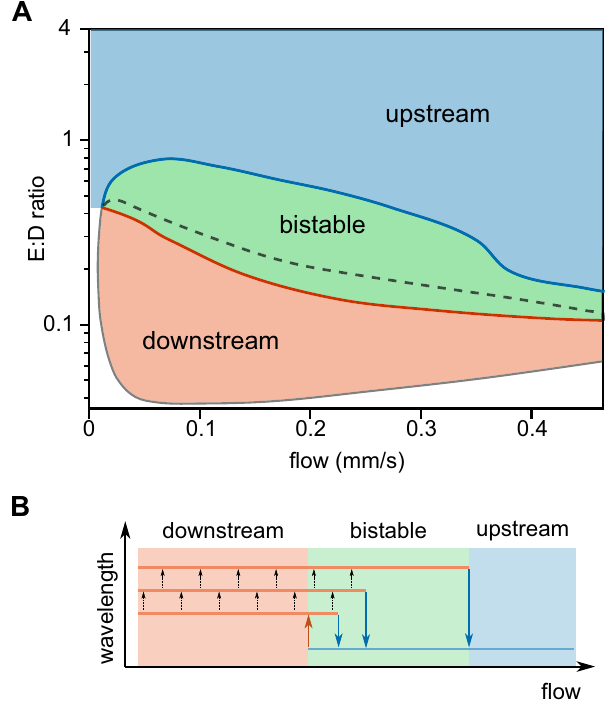
Fig. 3 | Phase diagram displaying the predicted direction of pattern propaga- tion. A Phase diagram displaying the predicted direction of pattern propagation. Red and blue regions indicate the parts of the parameter space where exclusively downstream or upstream patterns are observed, respectively. Green region indi- cates the multistability regime, where the propagation direction depends on the initial conditions. If simulations are initiated from the homogeneous steady state, the observed propagation direction is downstream below the black dashed line, and upstream above it. Details on the adiabatic parameter sweeps and the data points underlying the phase diagram are provided in SI Sec. S1.5 and Fig. S6. B Schematicvisualizingthatthetransition fl owvelocitydependsonthewavelength of the pattern. Upon increasing the fl ow velocity, larger wavelength patterns reverse the propagation direction at a higher fl ow